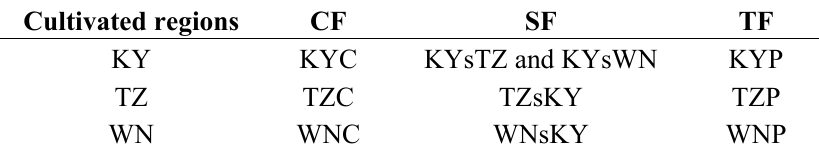
Table 7. RNA-seq samples subjected to various treatments. Cultivated regions CF SF TF KY KYC KYsTZ and KYsWN KYP TZ TZC TZsKY TZP WN WNC WNsKY WNP KYC, TZC, and WNC represent samples originating from KY, TZ, and WN without soil exchange and